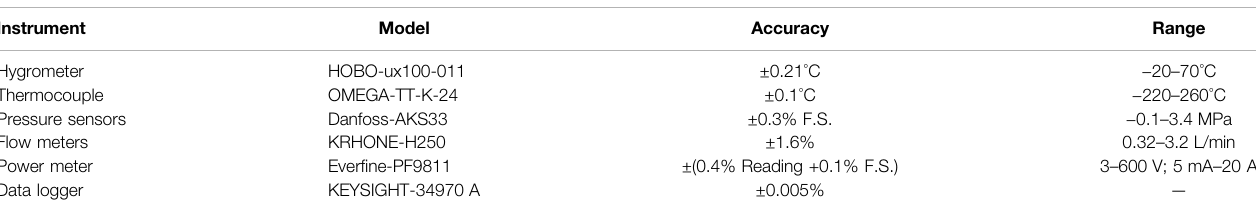
TABLE 1 | Speci fi c parameters of each measuring